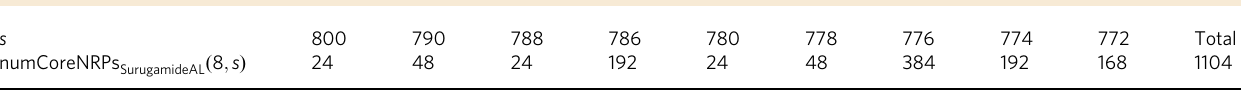
Table 3 Number of core NRPs of SurugamideAL (assembly line corresponding to cyclic surugamides A – D) according to their adenylation